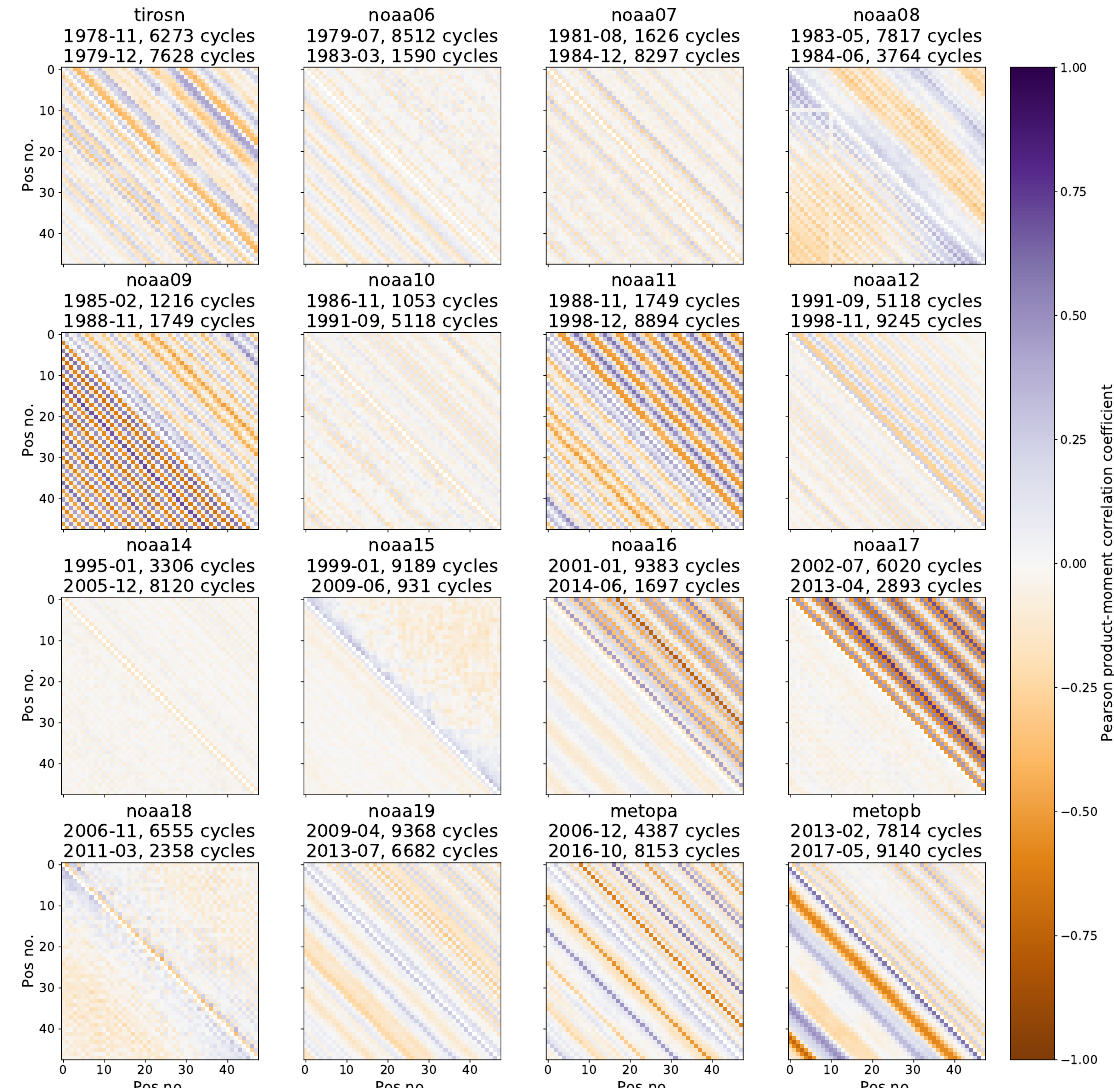
Figure 7. Pearson product-moment correlation between the error at different views within a set of calibration measurements (labelled “pos no”), channel 9, for the IWCT view. The lower triangle refers to a month early in the lifetime of each instrument, whereas the upper triangle refers to a month late in its lifetime, each indicated in the title above each